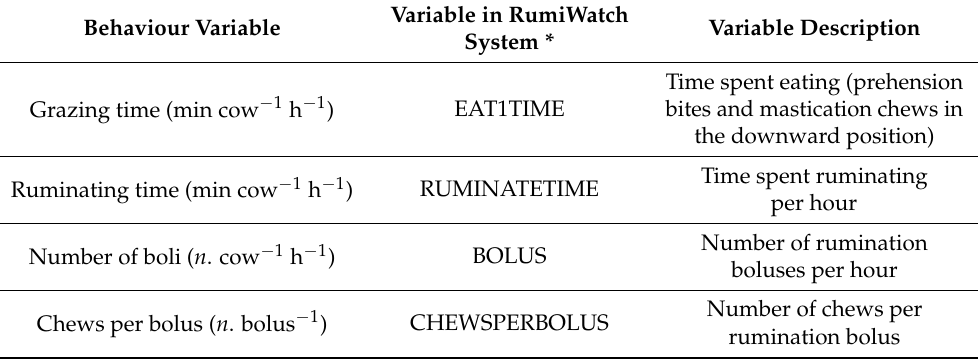
Table 1. Grazing behaviour parameters recorded using the RumiWatch sensor